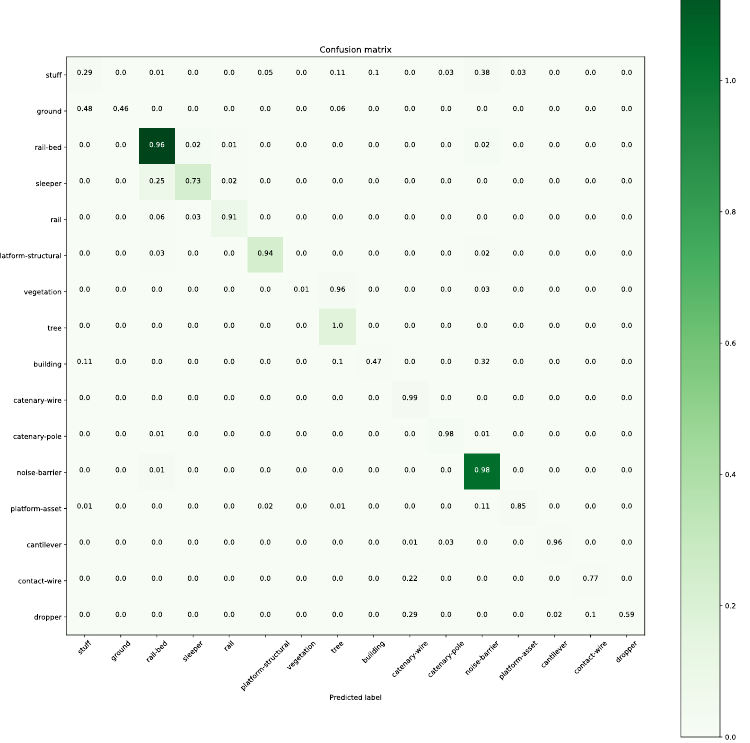
Figure A3. Confusion matrix for the 20% validation for step 70. The colour depicts the actual number of points in the validation